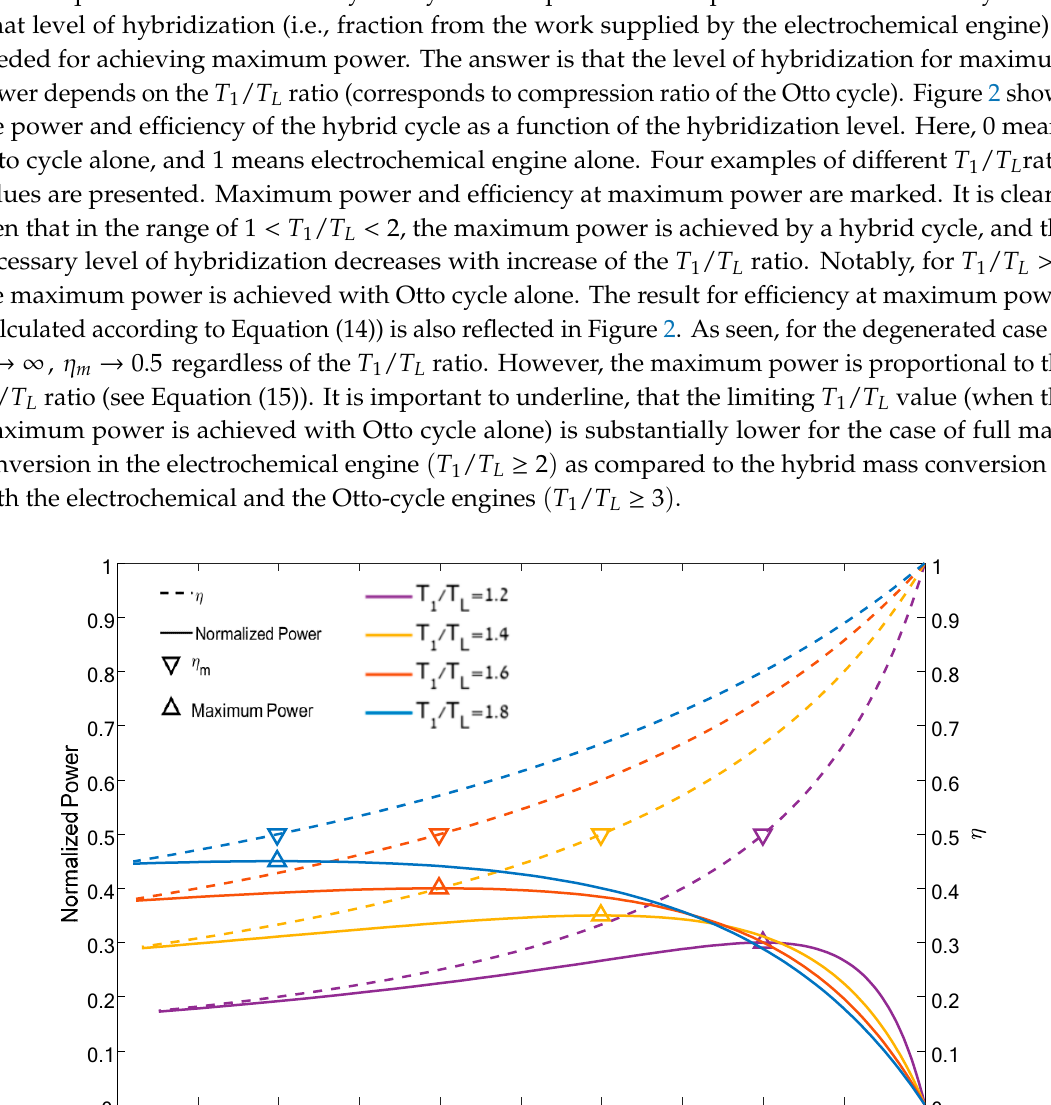
Figure 3. Temperature before expansion in the Otto cycle ( H T ) as a function of the chemical work fraction for different 1 / L T T ratios.  is a mark for H T at maximum power for each 1 / L T T ratio.